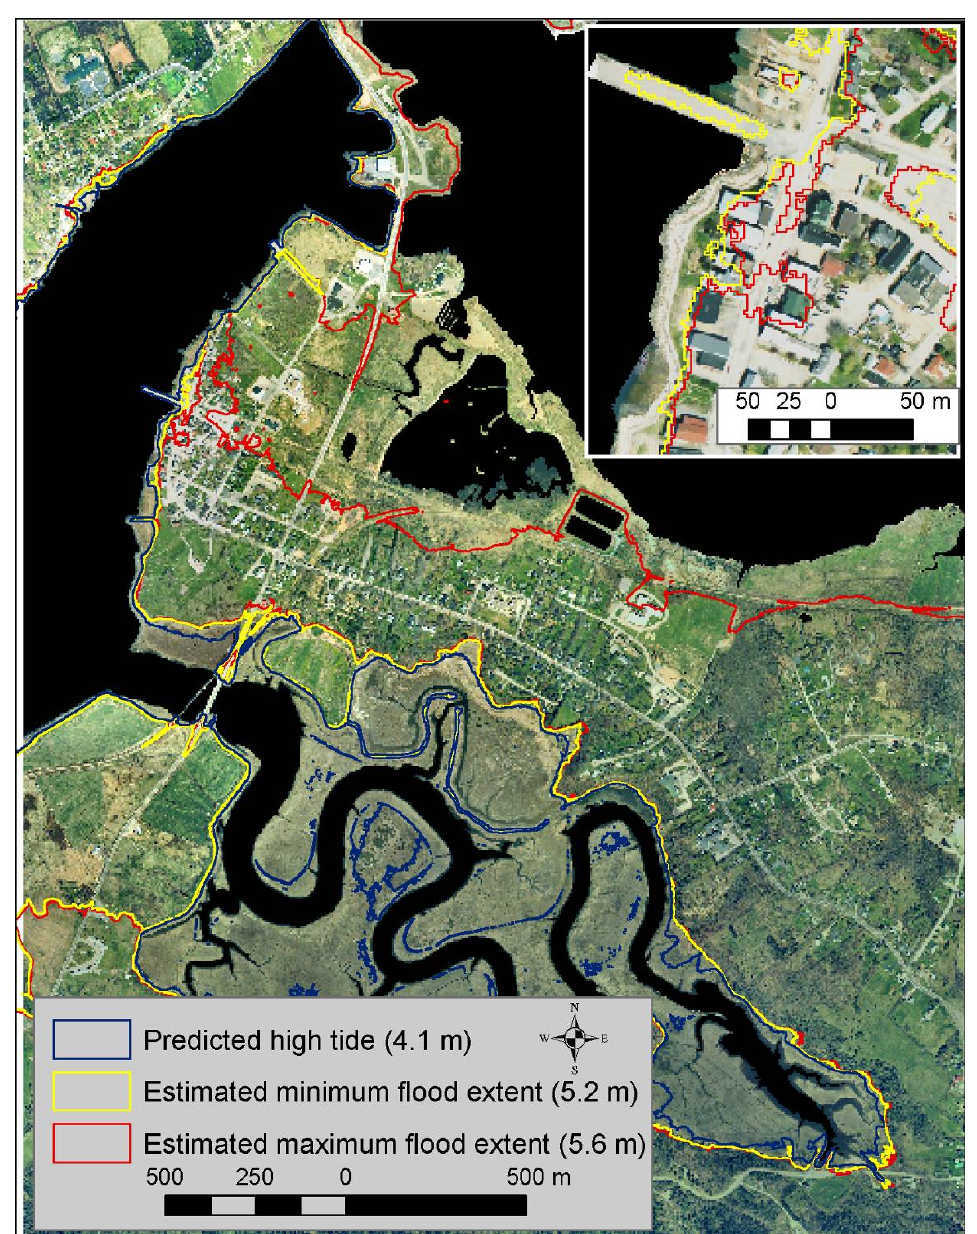
Figure 6. Modeled flood inundation area for a predicted tide (4.1 m) and storm surge; possible water level ranges (5.2–5.6 m) of the Groundhog Day storm, 1976. The background map is a color orthophoto acquired in May